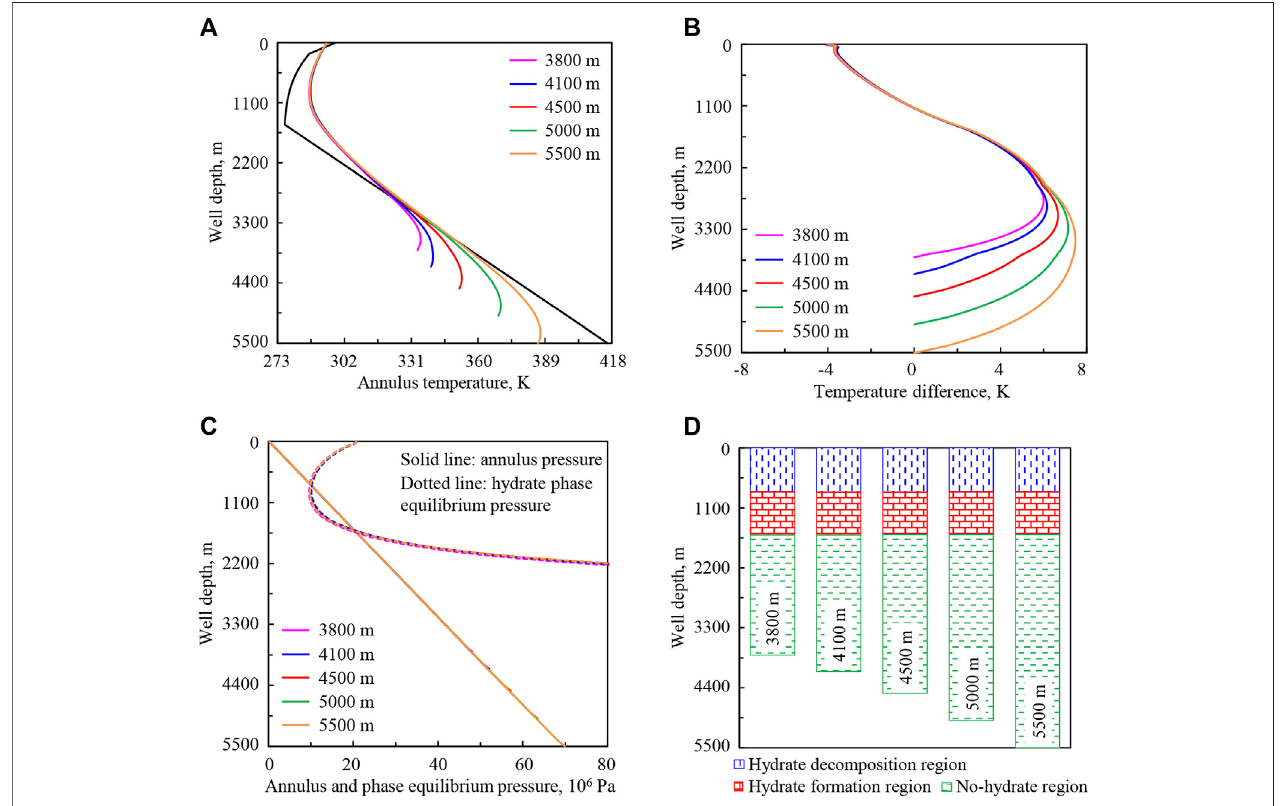
FIGURE 15 | Variation regularities of wellbore temperature fi eld, pressure fi eld, and hydrate formation region in deep-water drilling under different well depths: (A) annulus temperature, (B) temperature difference between the drilling fl uid in the annulus and in the drill string, (C) annulus pressure and phase equilibrium pressure, (D) hydrate formation region. The solid lines under different well depths in (C) are overlapped in the upper well section.